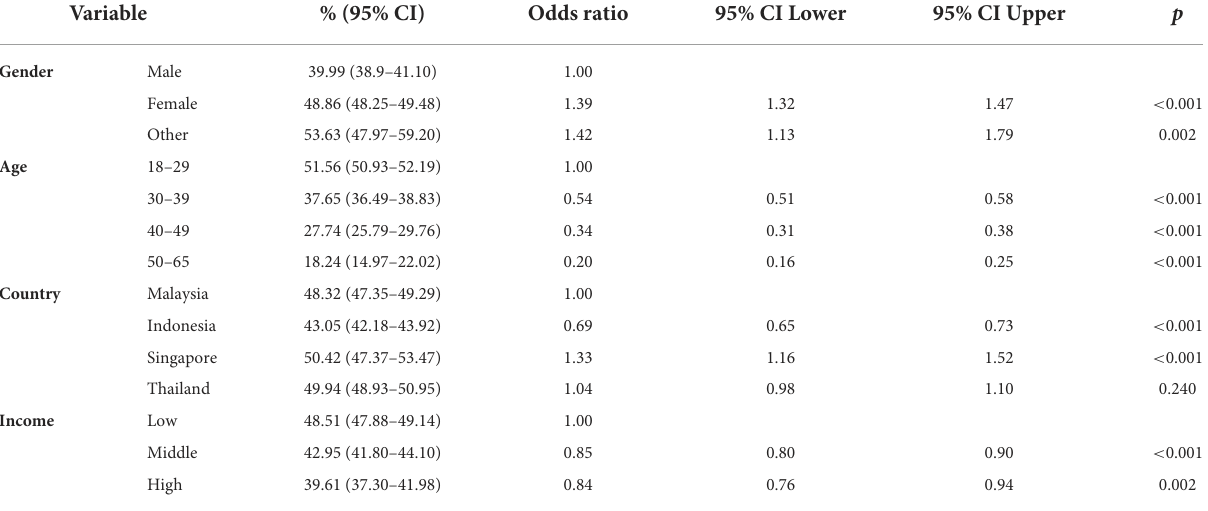
TABLE 4 Factors associated with severe/extremely severe depression